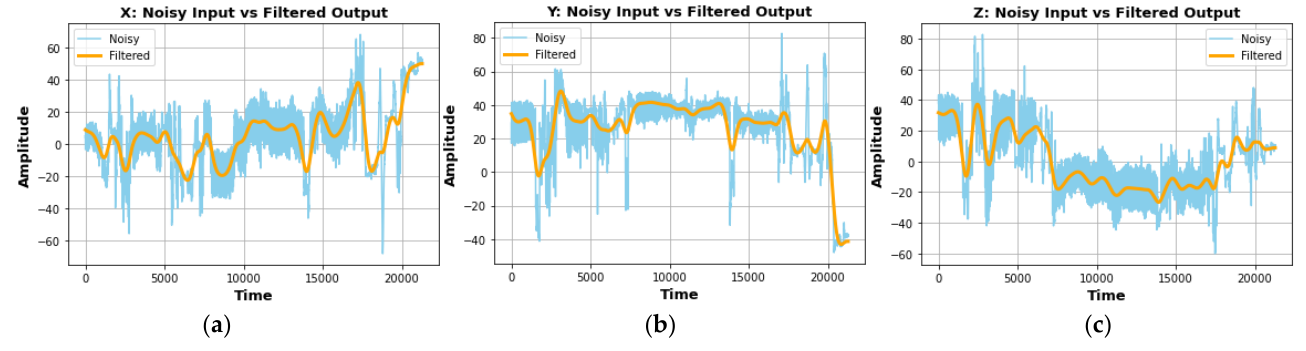
Figure 4. Signal denoising using second-order Chebyshev type-I filter with a cutoff frequency equal to 0.001. ( a ) Real-Life HAR magnetometer x-channel, ( b ) Real-Life HAR magnetometer y-channel, and ( c ) Real-Life HAR magnetometer z-channel.